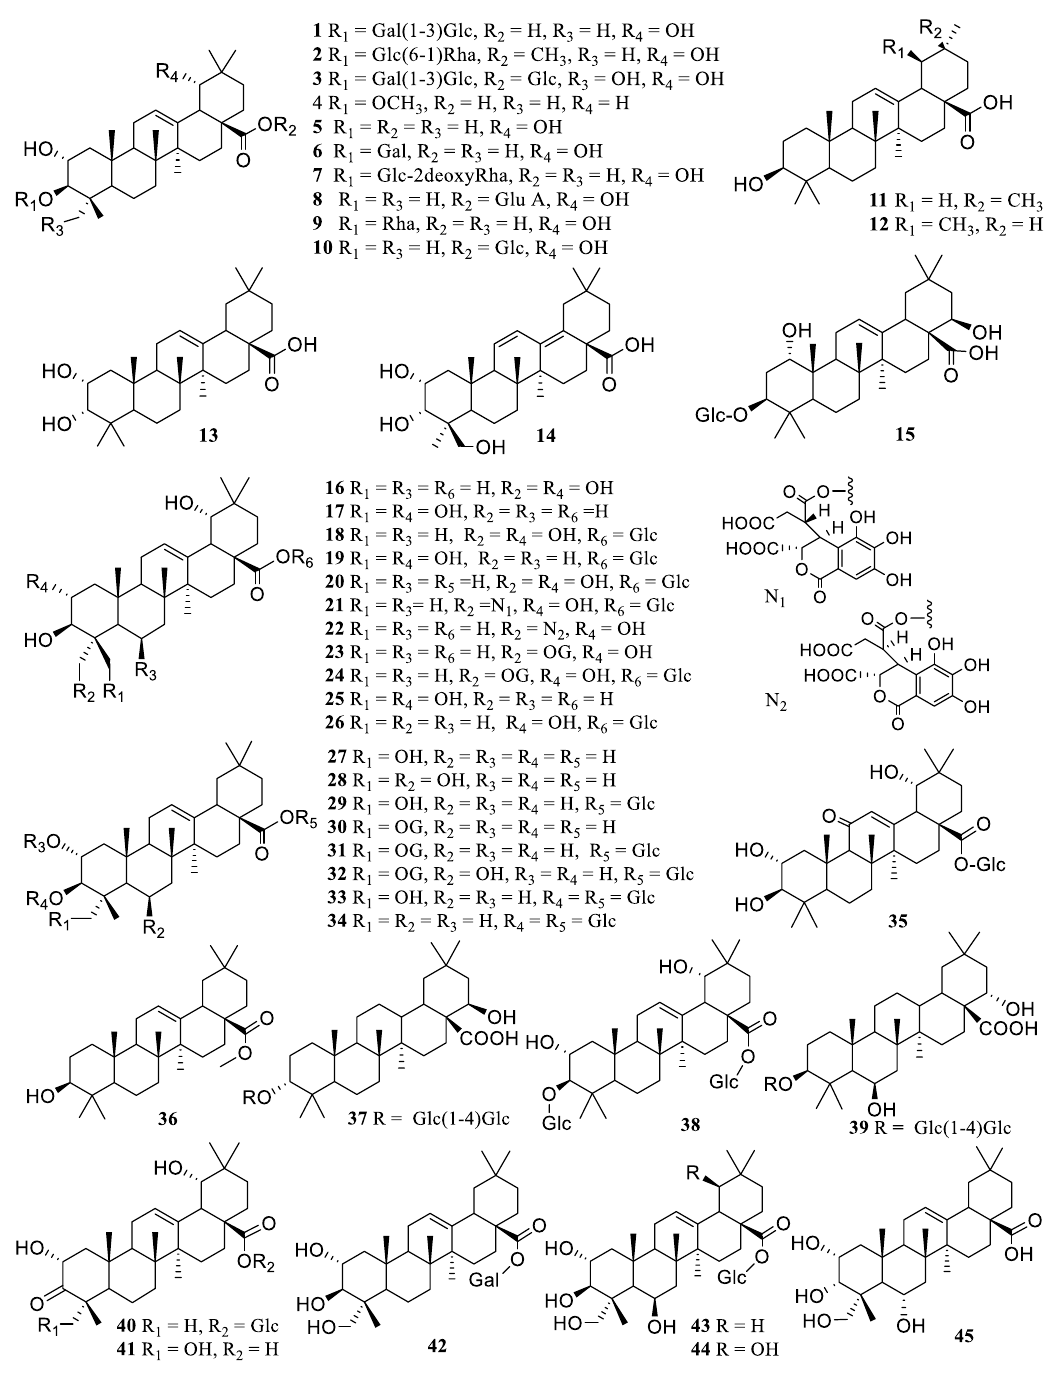
stem barks had promising effects (MIC = 1.25 mg/mL, both) [133].